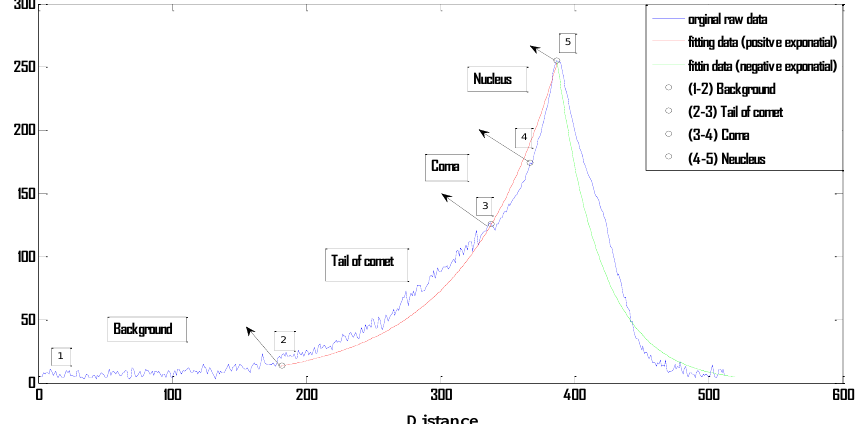
) as a function of plane, distance (x ,y). D